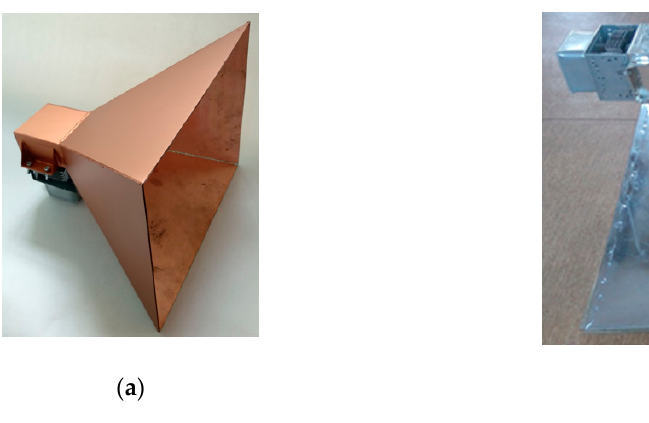
Figure 11. Emission antenna with a gain of ( a ) 17 dBi; ( b ) 18